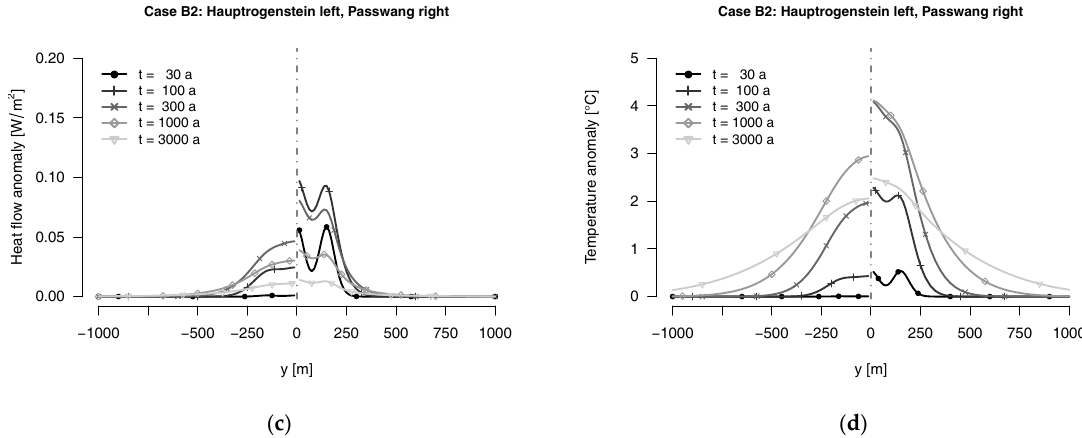
Figure 5. Examples of calculated y -profiles of heat flow and temperature anomalies at the possible water-bearing reference levels of the JO site; ( a,b ) case A; ( c,d ) case B2. Left side ( y < 0): Hauptrogenstein reference level; right side ( y > 0): Passwang reference level.